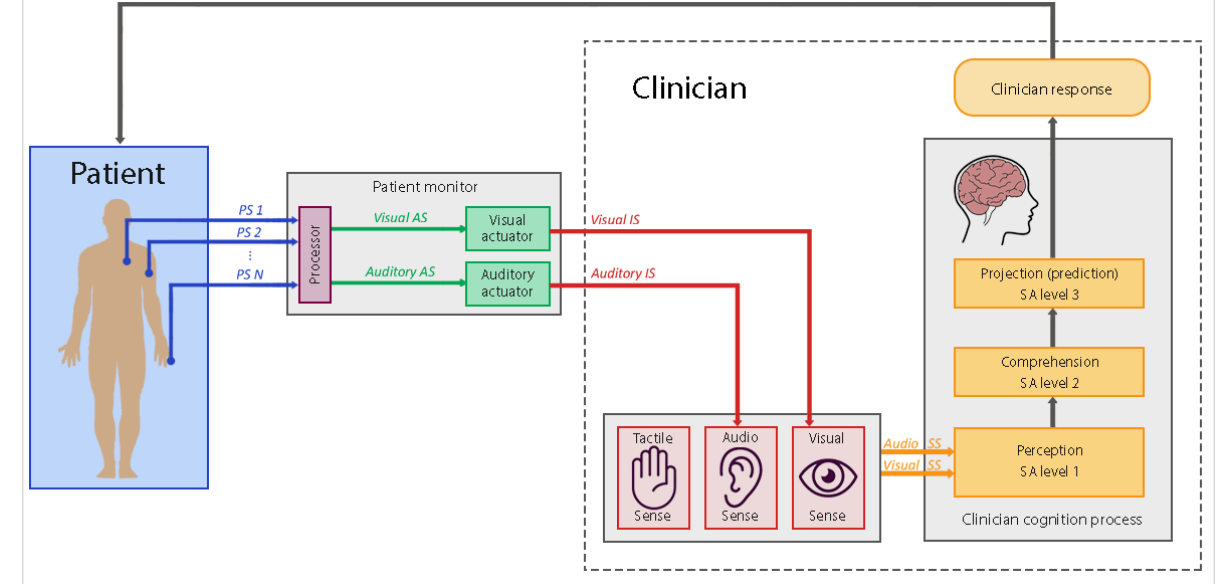
Figure 1. Patient monitor interaction mechanisms with the clinician. The patient’s physiological state is conveyed to the clinician through their visual and auditory senses. Once the clinician perceives a change in the patient’s state through these sensory signals, their cognition processes make use of this information (in addition to other contextual information) to comprehend the patient’s current state and make projections of their future state. At the end of this process, clinicians can make a decision on what they should do next regarding the patient’s care. AS: actuator signal; EDS: external device signal; IS: interaction signal; PS: physiological signal; SS: sensory